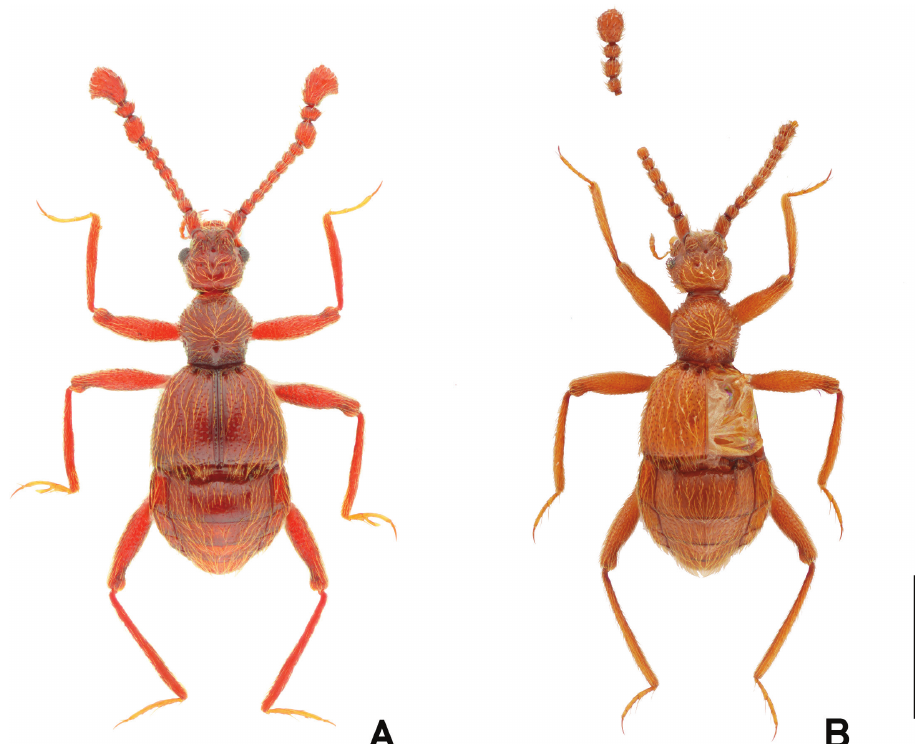
Figure 5. Dorsal habitus of Pseudophanias nakanoi A male B female. Scale bar: 1.0